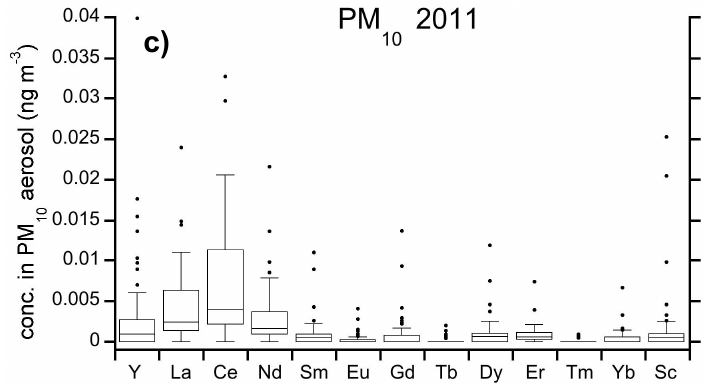
Figure 16. Box plot of trace metal concentrations measured in PM10 aerosol during the AREX 2011 cruise. In order to differentiate the value distribution of all metals, the determined parameters were classified as “major trace” ( a ), “minor trace” ( b ), and “REEs” ( c ).